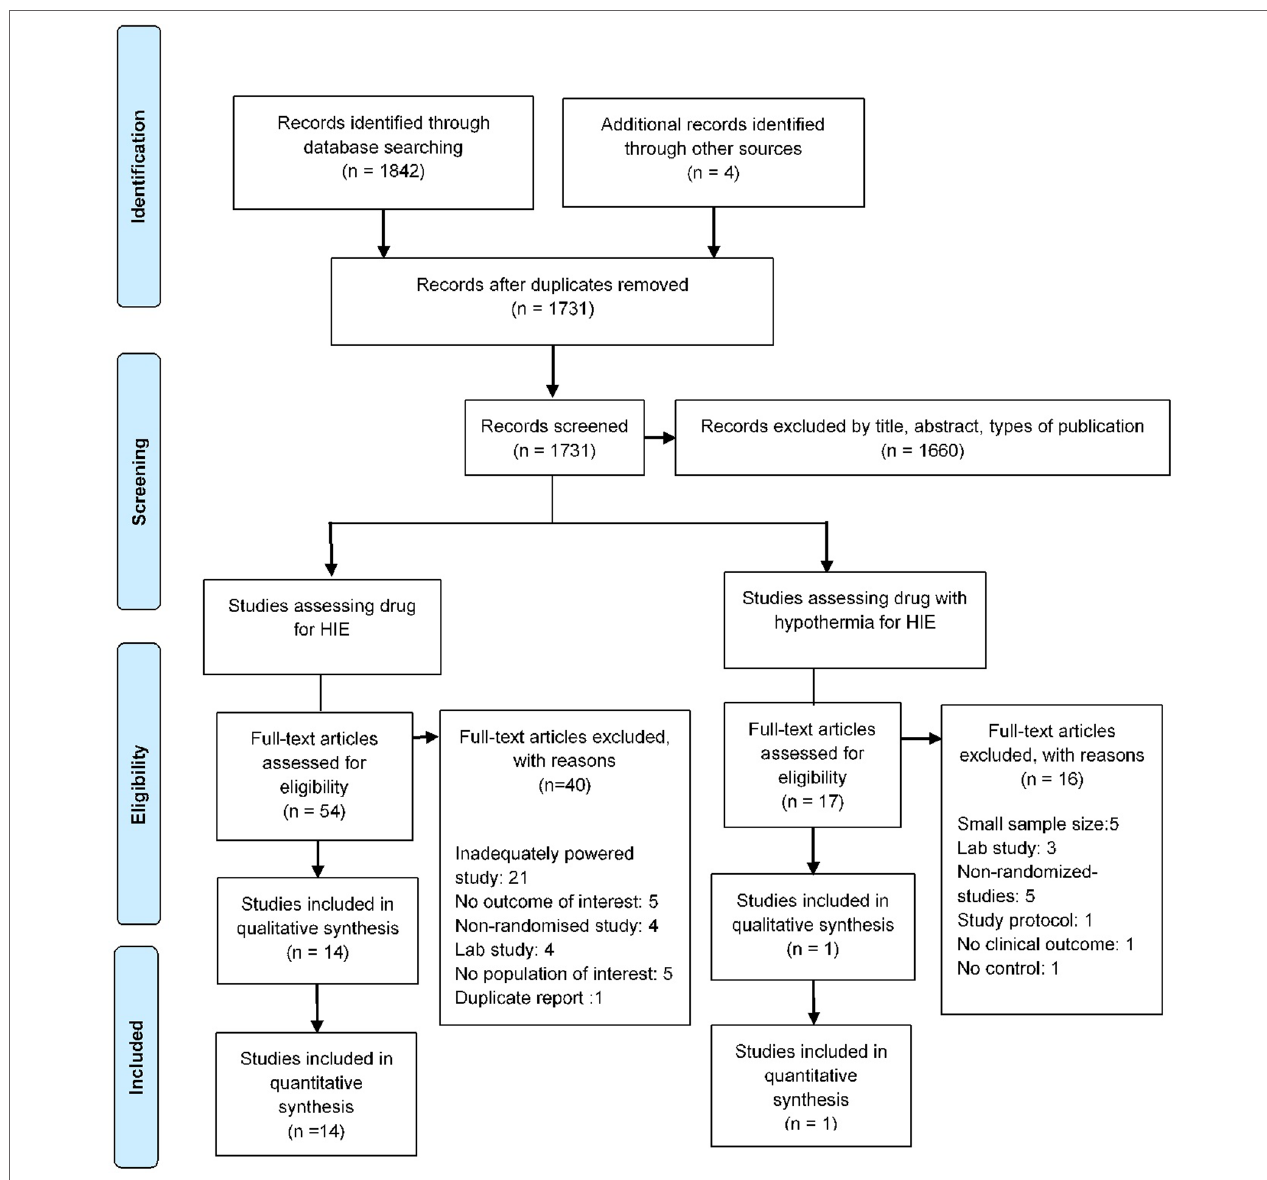
FIGURE 1 | Study flow detailing the screening, identification, and selection